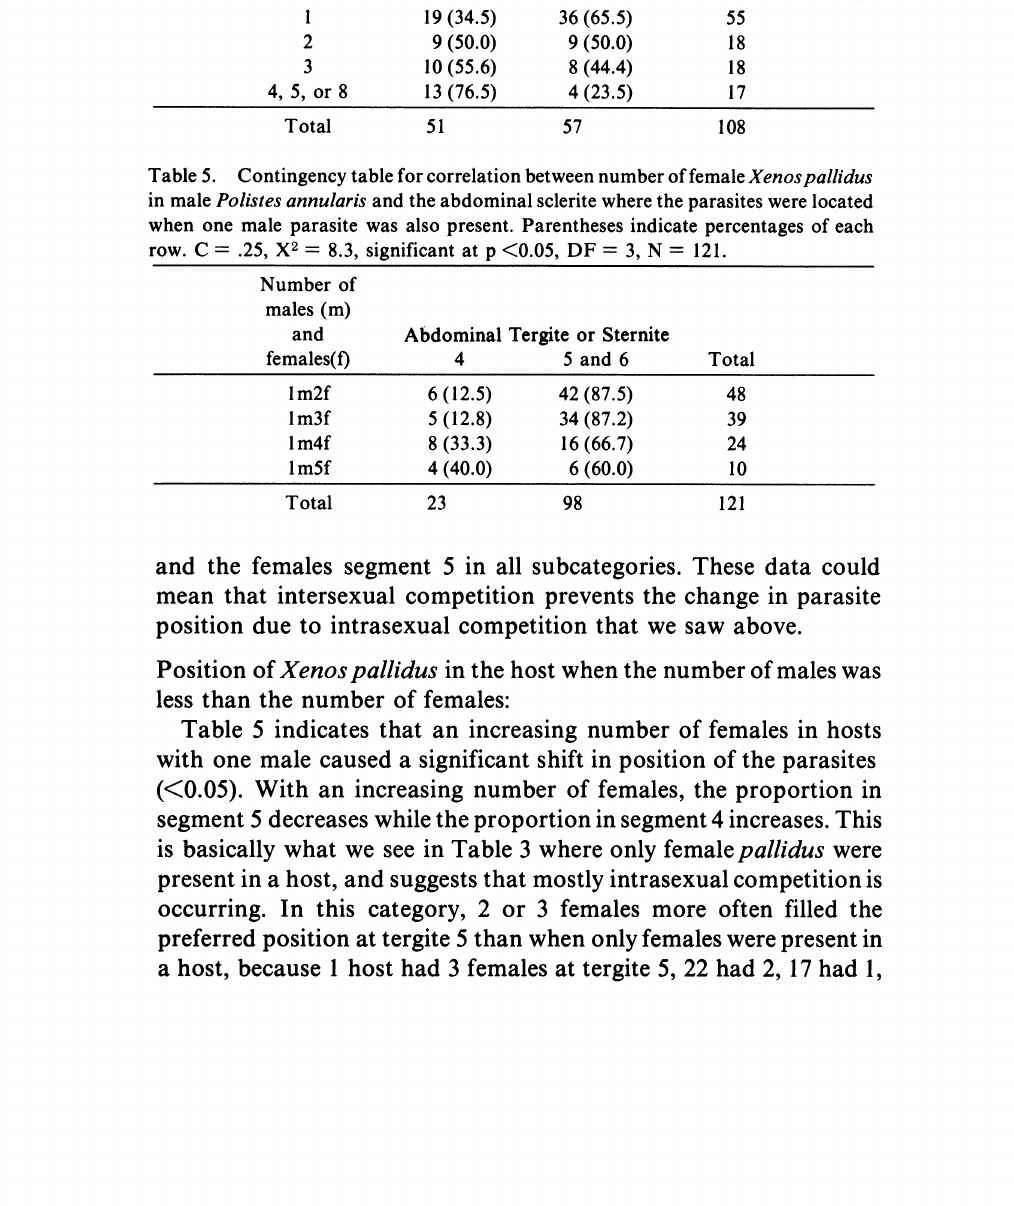
Table 5. Contingency table for correlation between number of female Xenospallidus in male Polistes annularis and the abdominal sclerite where the parasites were located when one male parasite was also present. Parentheses indicate percentages of each row. C .25,